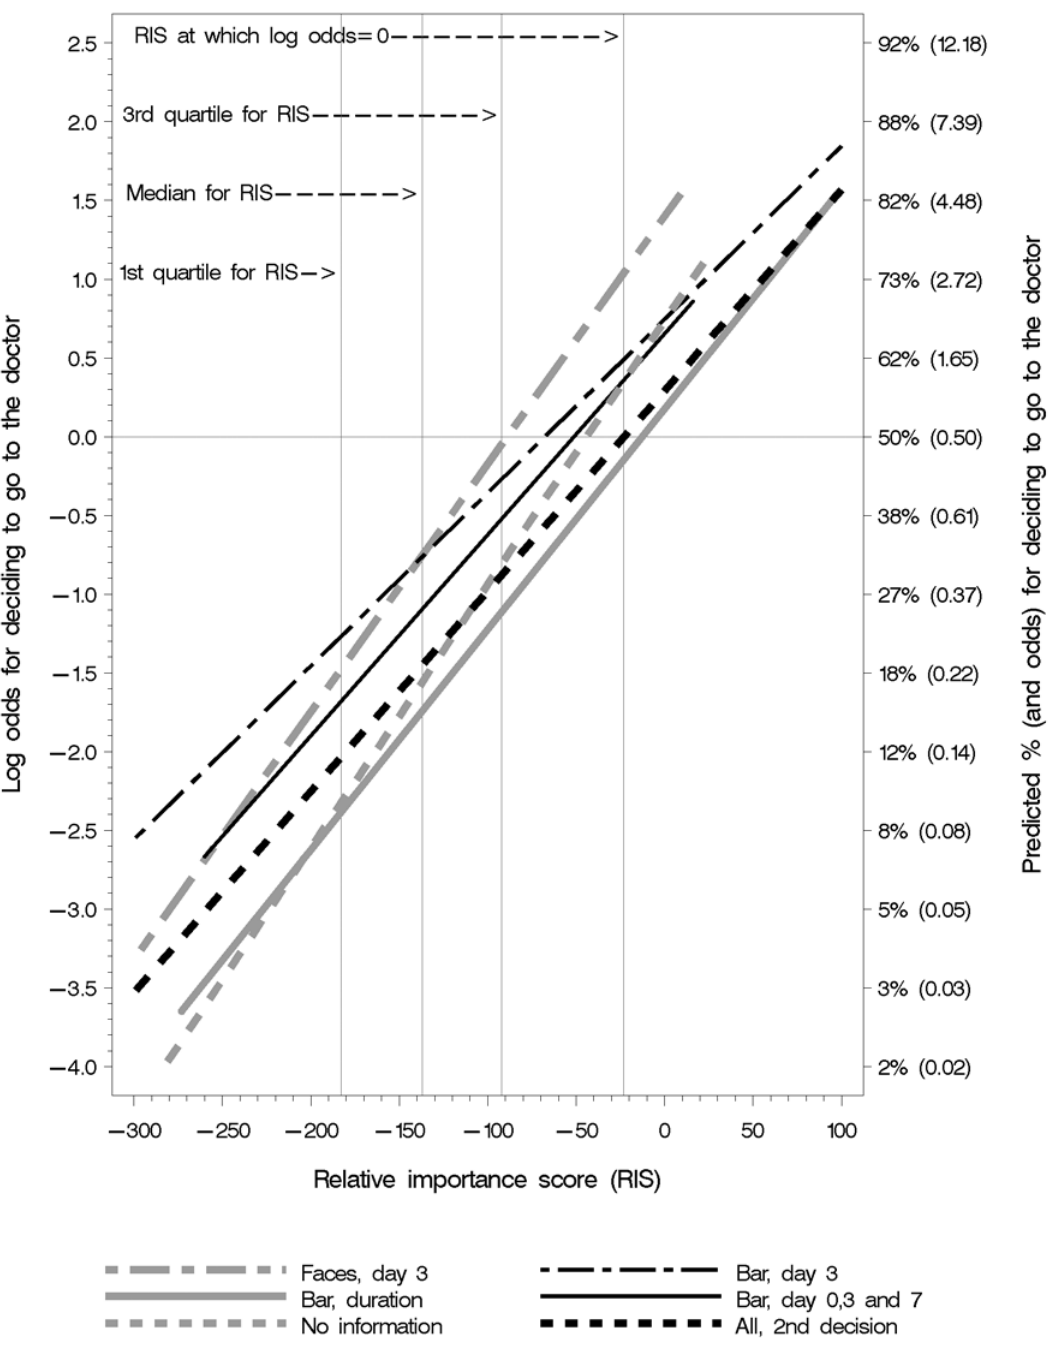
Figure 4. Likelihood of deciding to go to the doctor in relation to RIS. Relative importance score (RIS) values indicate the relative importance to participants of the desirable and undesirable consequences of getting and taking antibiotics. As anticipated, the likelihood of participants deciding to go to the doctor is greater when the relative importance of the desirable consequences (a shorter duration of sore throat) is greater and the relative importance of the downsides of getting and taking antibiotics is less.